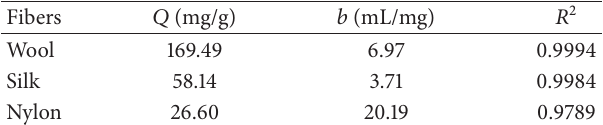
Table 2: Langmuir adsorption parameters of lac dyes on wool, silk and